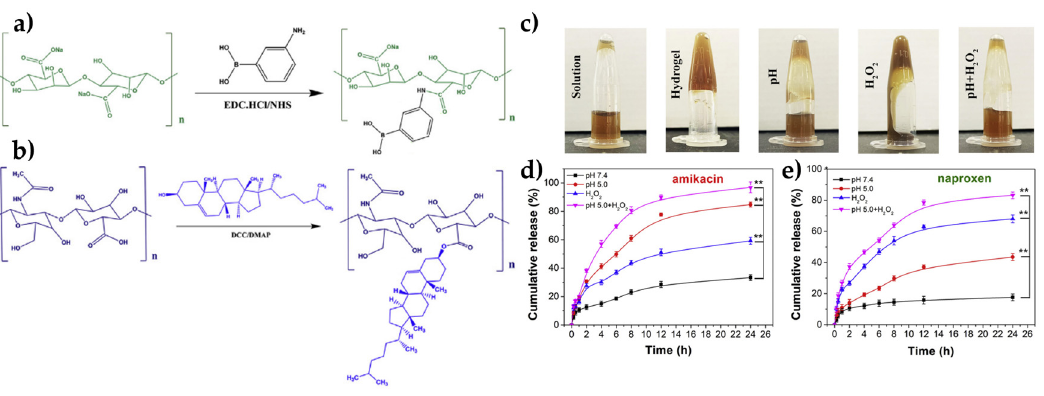
Figure 7. Schematic representation of the synthetic process followed for the synthesis of ALG-BA ( a ) and HA-CHOL ( b ). Photographs showing the formation of the hydrogel and its stimuli-responsive behavior ( c ) and percentage cumulative release of amikacin ( d ) and naproxen ( e ) from the hydrogels as a function of time for different incubation conditions (mean ± SD, n = 3), * p < 0.01, ** p < 0.001. Adapted with permission from [57].